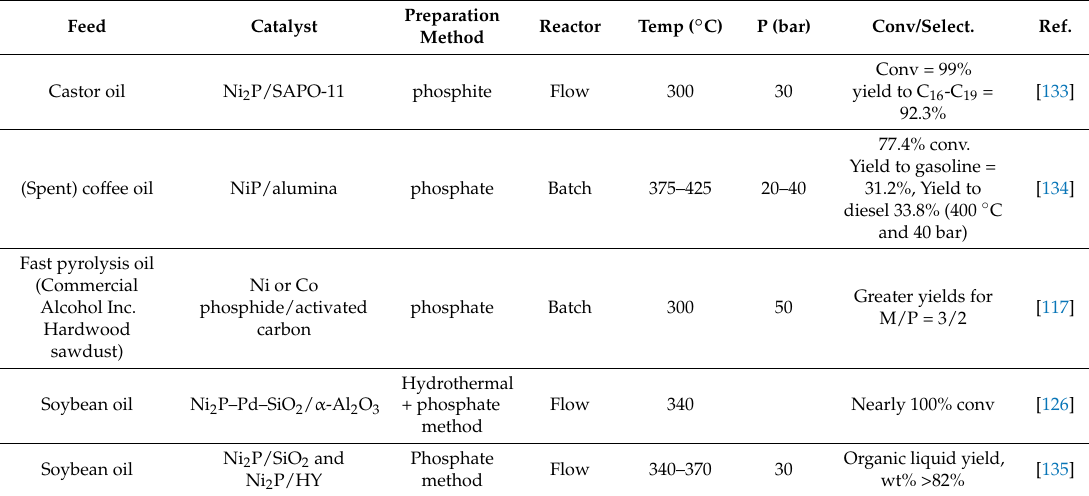
Table 3. Some literature studies on HDO of hydrotreated vegetable oils, HVO (real